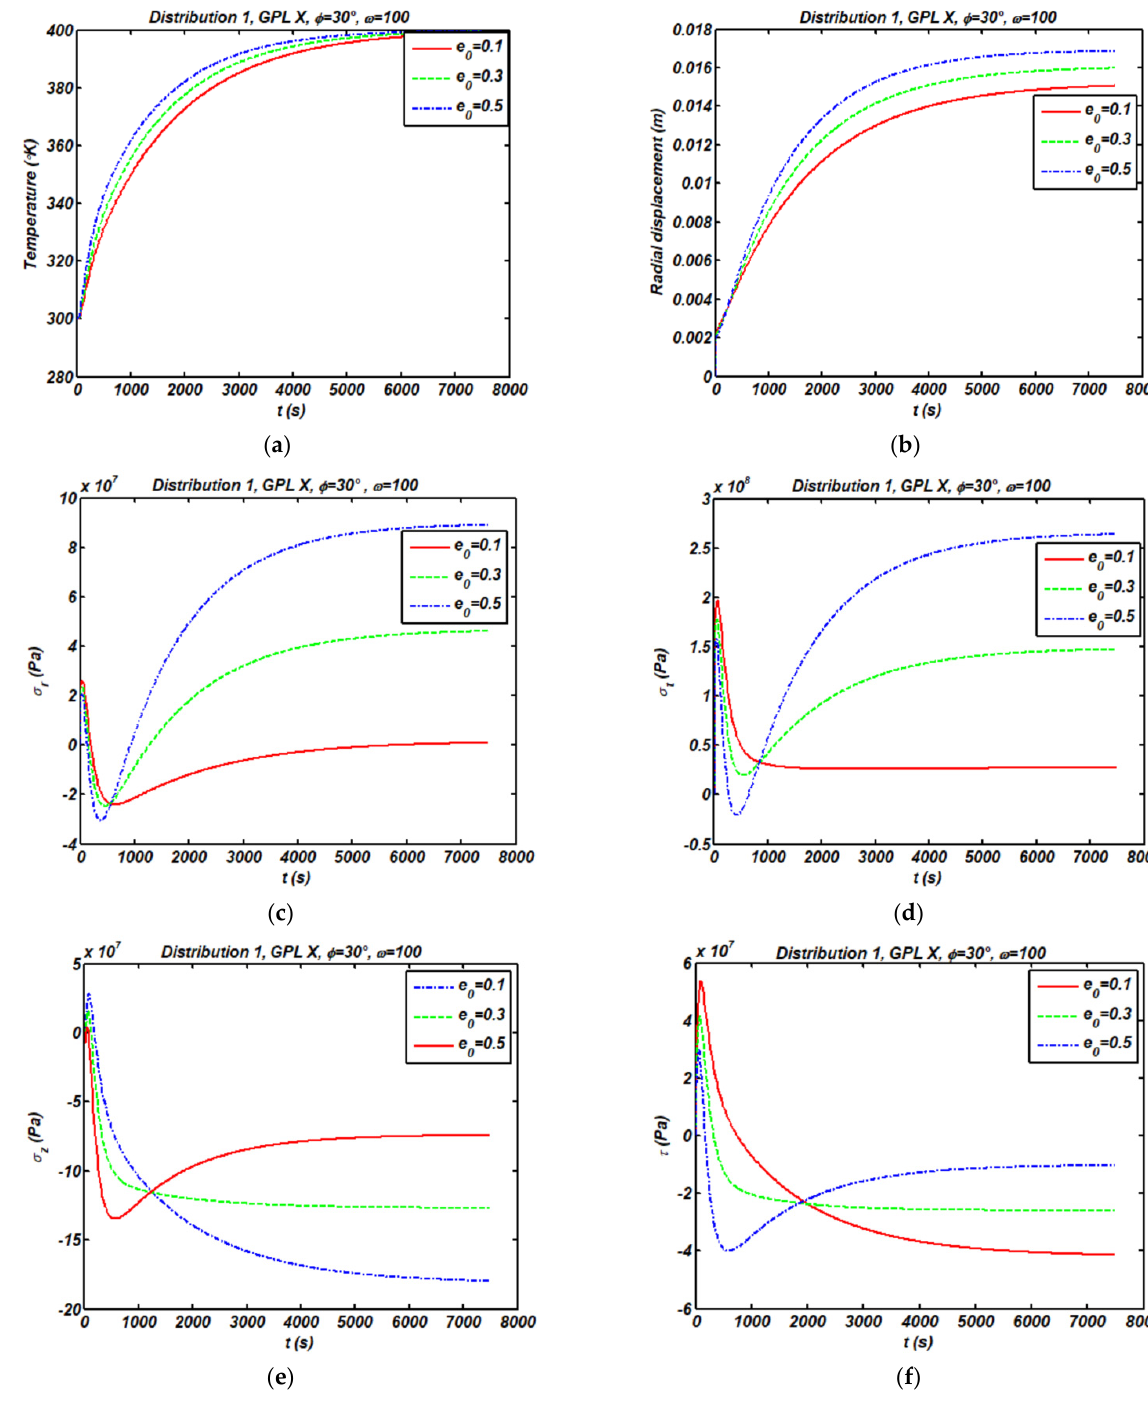
Figure 6. Influence of porosity coefficient on the transient temperature ( a ), radial displacement ( b ), and stress state ( c – f ) for a center point of truncated cone (D1-GPL X; φ = 30 ◦ ; γ GPL = 0.01; ω = 100 rad/s).